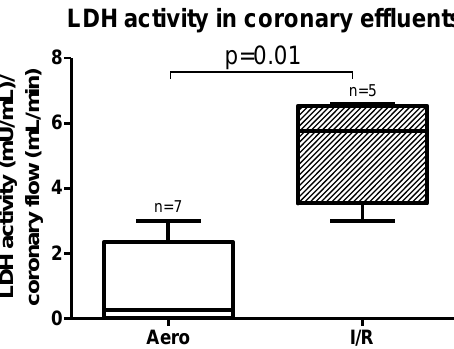
Figure 2. Lactate dehydrogenase (LDH) activity in coronary e ffl uent after ischemia / reperfusion (I / R) and in aerobic conditions; all data are expressed as mean ± SEM.